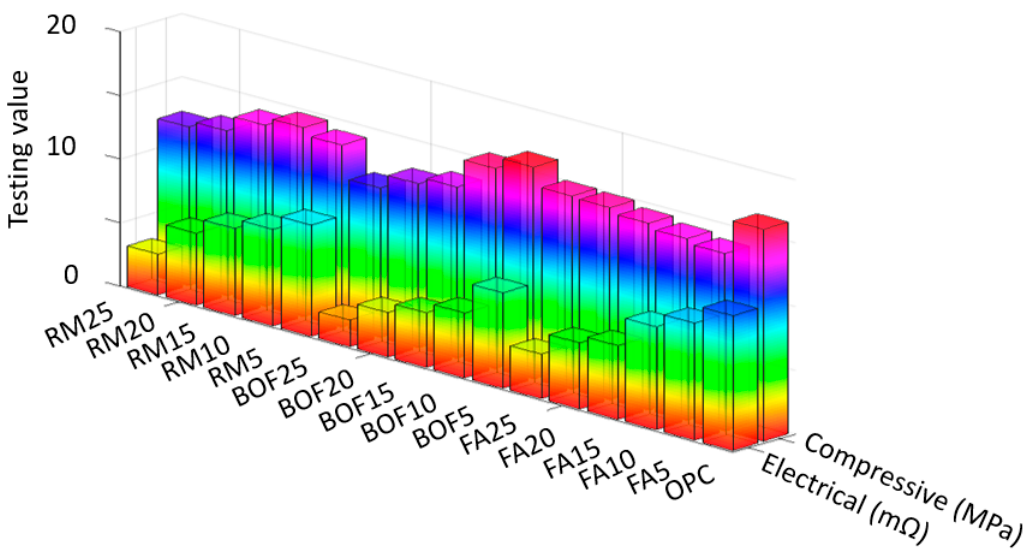
Figure 6. Compressive strength and electrical resistance results for the environment-friendly, self-sensing concrete cured at the age of 3 days.